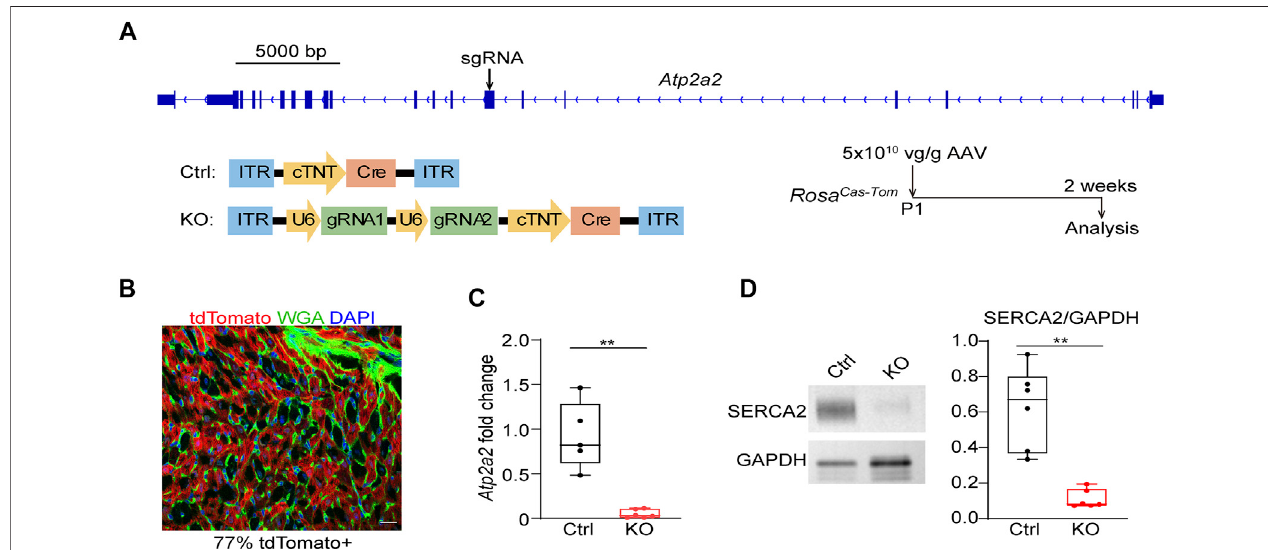
FIGURE2 | The establishment ofCASAAV-based Atp2a2 mutagenesis. (A) , Design of Atp2a2-targeted sgRNAs and CASAAV-based knockout experiments. (B) , A confocal image of the cardiac section treated with high-dose AAVs mediating Atp2a2 knockout. Scale bar, 20 μ m. (C) , Quantitative real-time PCR analysis of heart tissues treated with high-dose control and Atp2a2 knockout AAVs. (D) , Western blot analysis and quanti fi cation of heart tissues treated with high-dose control and Atp2a2 knockoutAAVs.In C and D ,BoxandWhiskerplotswerepresentedtoshowindividualdatapoints(dots),25%-50% – 75%percentiles(horizontallinesinthe boxes) and maximal/minimal values (whiskers). Unpaired two-tailed student ’ s t-test: ** p < 0.01, *** p < 0.001.